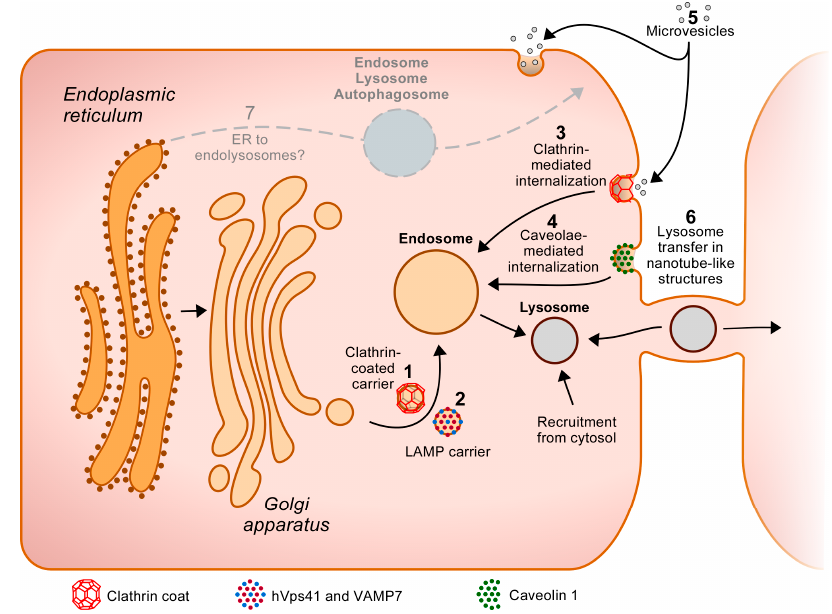
Figure 2. Sorting pathways to the endolysosomes. Newly synthesized lysosomal proteins are transported to the Golgi apparatus from where they reach the endosomes and, subsequently the lysosomes. One of the main transport pathways followed by these proteins is a direct route from the TGN to the endosomes ( 1 ). The lysosomal transmembrane proteins and acid hydrolase receptors (MPRs, sortilin, SEZ6L2) that are bound to their ligands are packaged at the TGN in clathrin-coated carriers that travel toward the endosomes. This packaging is driven by the binding of typical cytosolic tyrosine- or dileucine-based sorting signals, or of atypical motifs, to clathrin adaptor proteins (directly or through some other proteins). Alternatively, some transmembrane proteins (including LAMP1 and LAMP2) can be transported directly from the TGN to the endosomes in non-clathrin-coated vesicles (“LAMP carriers”) that are positive for hVps41 and VAMP7 ( 2 ). Lysosomal proteins that are not packaged in transport vesicles at the TGN, and escape to the cell surface as a consequence, can be recaptured by clathrin-mediated internalization, which is also based on the recognition of cytosolic sorting motifs by PM clathrin adaptor proteins ( 3 ). In addition, LAMP3 has been found to enter the endolysosomal system by caveolin-mediated internalization ( 4 ). Of note, some lysosomal proteins may piggyback on others to enter some of these pathways (as indicated in Table 1). The cells can also acquire some lysosomal proteins from other cells, e.g., through the capture of microvesicles by clathrin-dependent and -independent mechanisms ( 5 ) or subsequently to the transfer of exogenous lysosomes through nanotube-like structures tunneling between some cells ( 6 ). Lastly, some proportion of lysosomal proteins could, hypothetically, bypass the Golgi apparatus to reach endolysosomes or autophagosomes (which could then fuse with lysosomes) directly from the ER, or after sorting from the ER to the PM and subsequent internalization from this site ( 7 ).